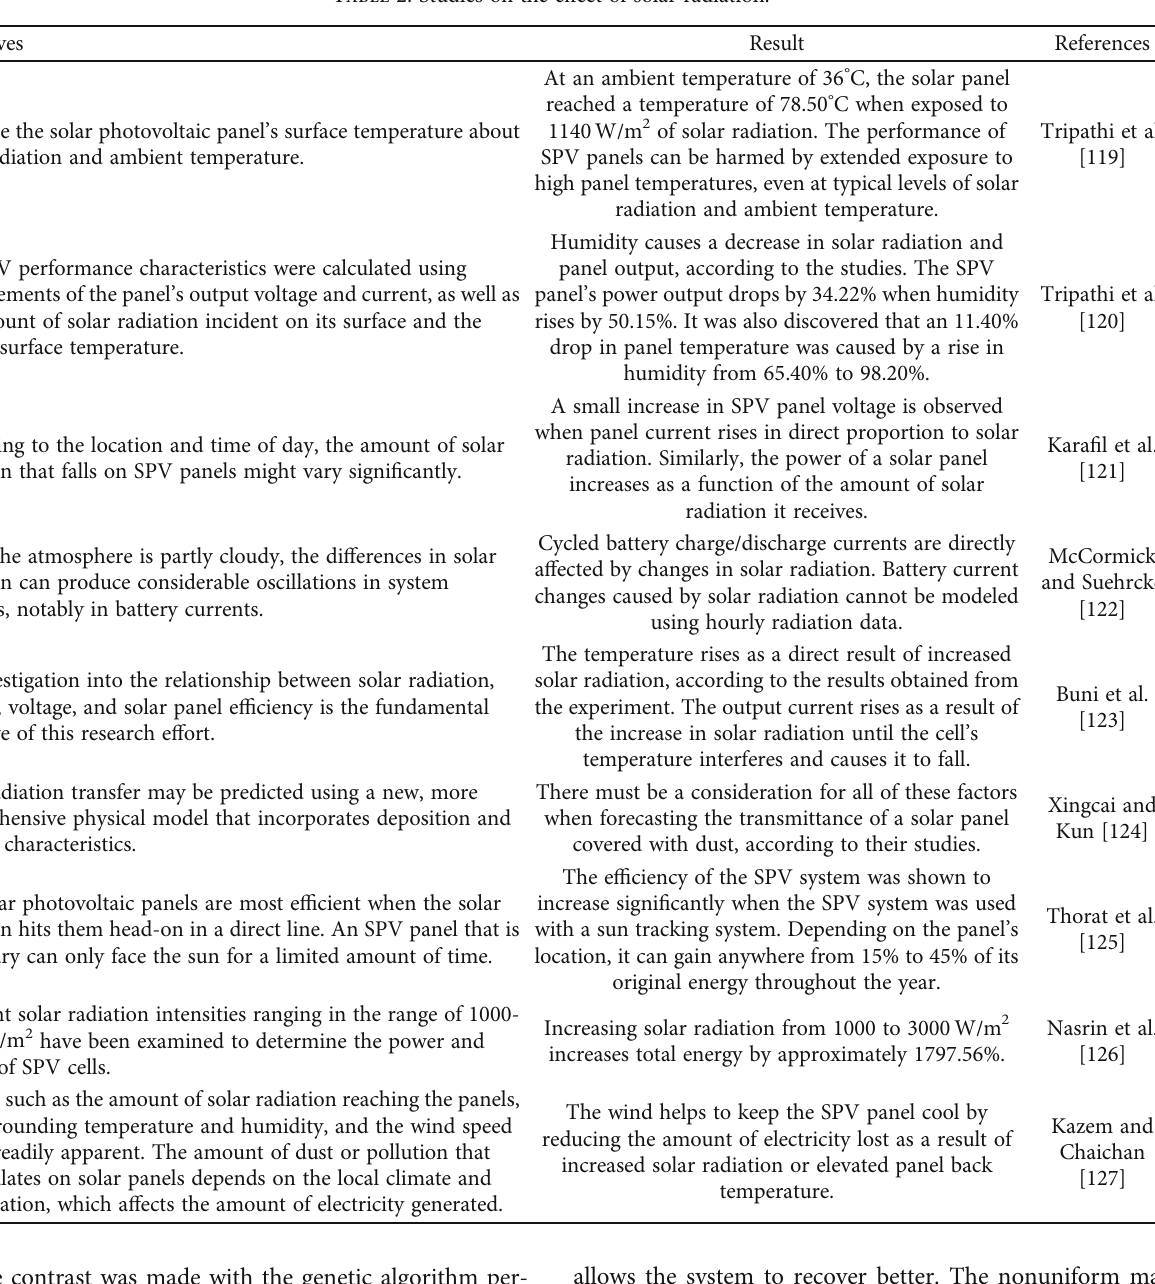
Table 2: Studies on the e ff ect of solar